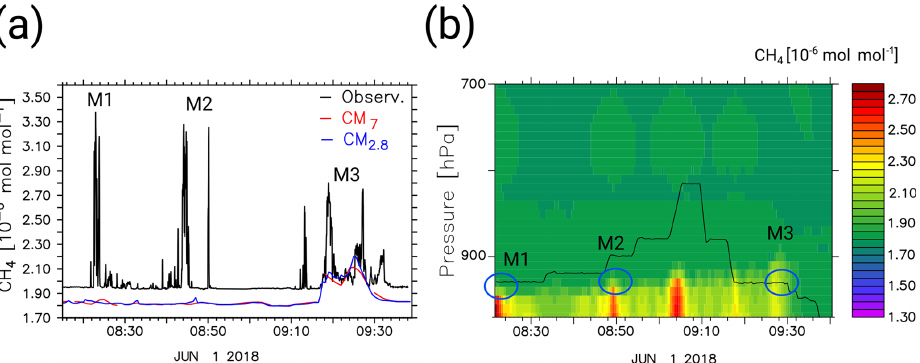
Figure 12. Panel (a) shows the D-FDLR in situ sampled CH 4 mixing ratios (black lines) of P2 and the S4D submodel output of CH4_FX at flight altitude for CM7 (red) and CM2.8 (blue). Panel (b) displays the corresponding flight altitude of P2 (black line) and the simulated profile (CM2.8) of the methane mixing ratio along this flight track. All mixing ratios are in micromoles per mole (µmolmol − 1 ). The time axes display the time of the flight in UTC. M1, M2 and M3 mark specific methane peaks seen in the observation (a) and in the simulated methane profile (b) , but not necessarily in the sampled S4D output at flight altitude (a) .